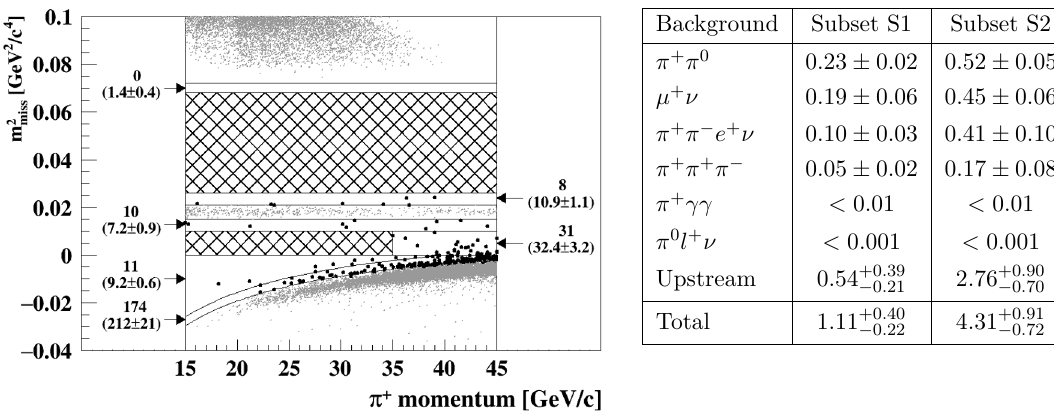
as a function of π + momentum Figure 6 . Background predictions. Left: reconstructed m 2 miss after applying the signal selection to the S1 and S2 subsets. Events in the background regions are displayed as light grey dots. The control regions, populated by the solid black markers, are adjacent to the background regions. The numbers next to these regions are the expected numbers of background events (in brackets) and the observed numbers (without brackets). Right: expected numbers of background events summed over Regions 1 and 2 in the 2018